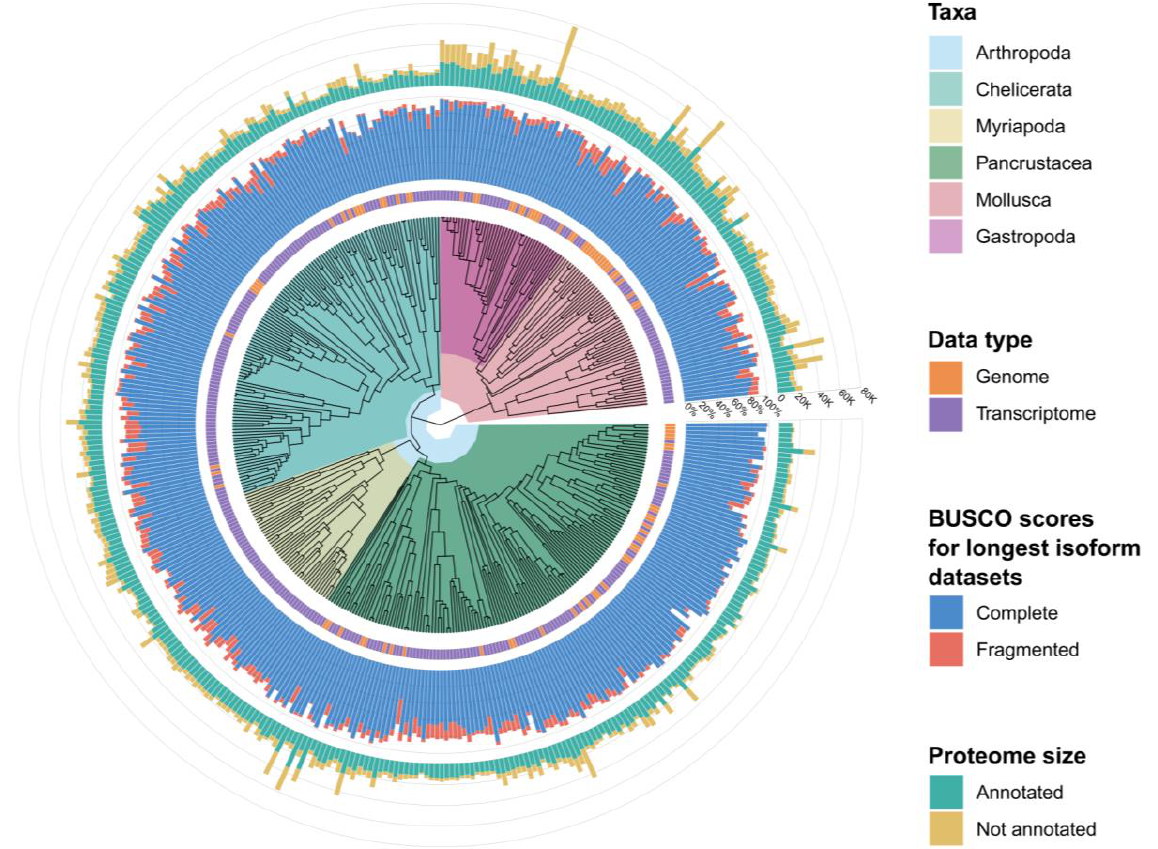
Figure 1. Taxonomic representation of taxa included in MATEdb v1. Taxonomic rank (e.g., phylum, class, etc.), data type (i.e., genome or transcriptome), BUSCO score for the longest isoform datasets and proteome size is shown in the outer